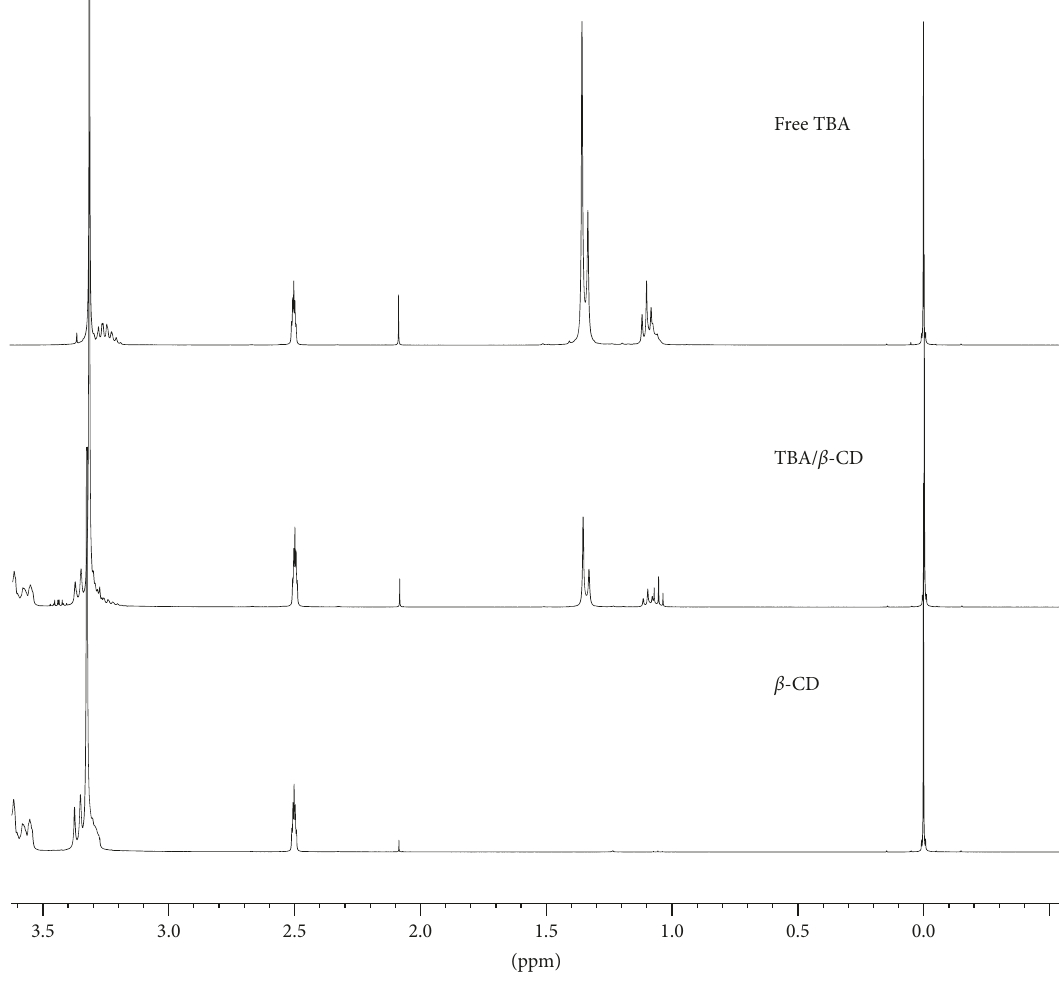
Figure 6: 1 H NMR spectra of TBA, 𝛽 -CD, and TBA/ 𝛽 -CD complex in DMSO-d 6